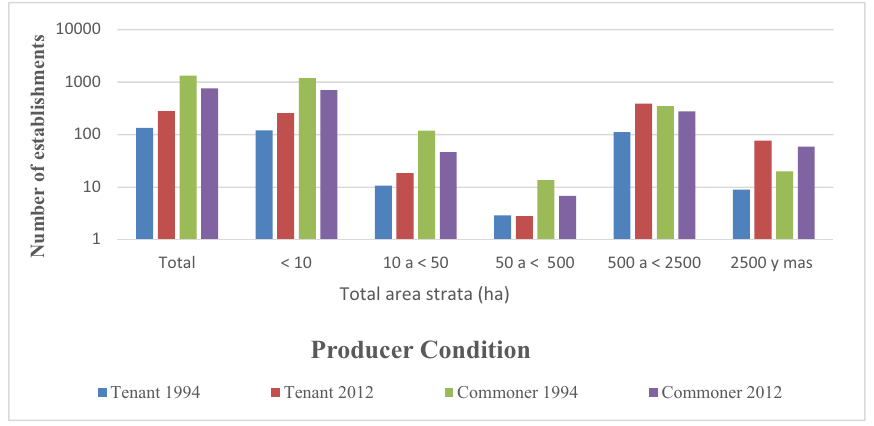
Figure 4: Number of establishments in Peru by area strata managed by tenants and commoner in 1994 and 2012. Source: Own elaboration from ref. [ 51 ] .